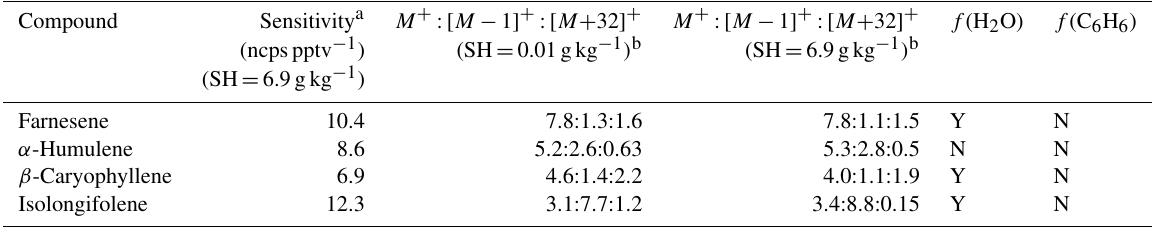
Table 2. Sesquiterpene sensitivities and dependence on operating and sampling conditions. Compound